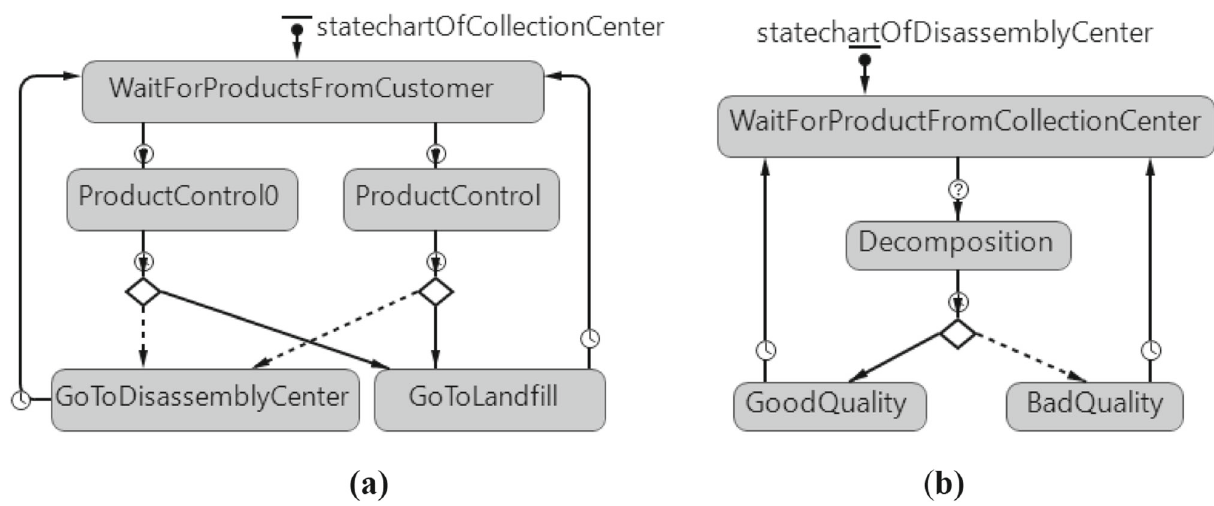
Fig. 7 a Statechart of collection center agent. b Statechart of disassembly center